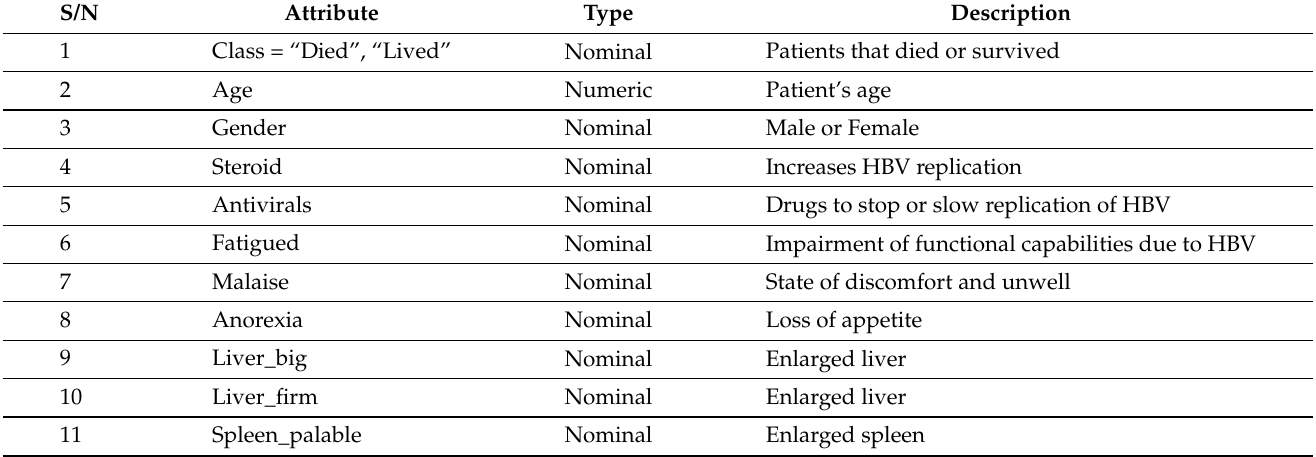
Table 1. Dataset